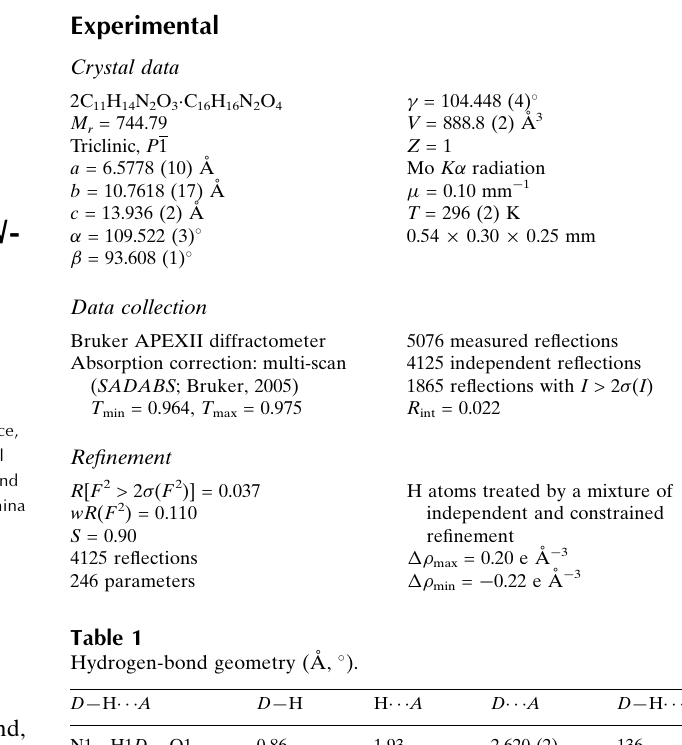
The asymmetric unit of the title compound,